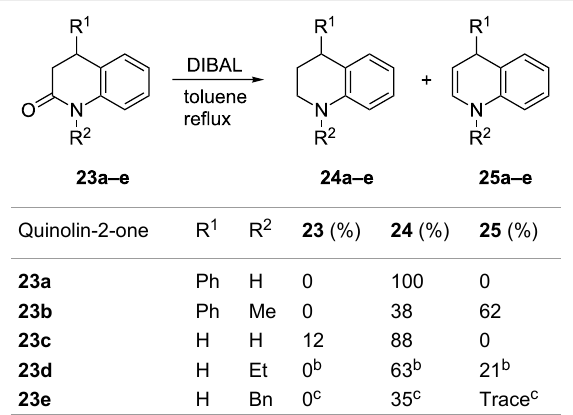
H Bn 0 c 35 c Trace